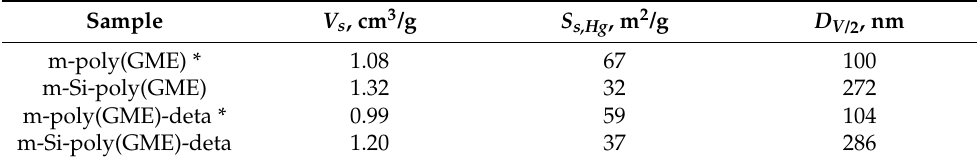
Table 1. Porosity parameters of investigated samples.